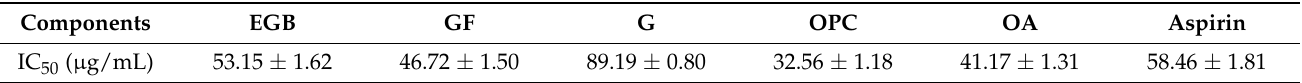
Table 1. The IC 50 value of NO in Raws264.7 cells of LPS inhibited by functional components of EGB.